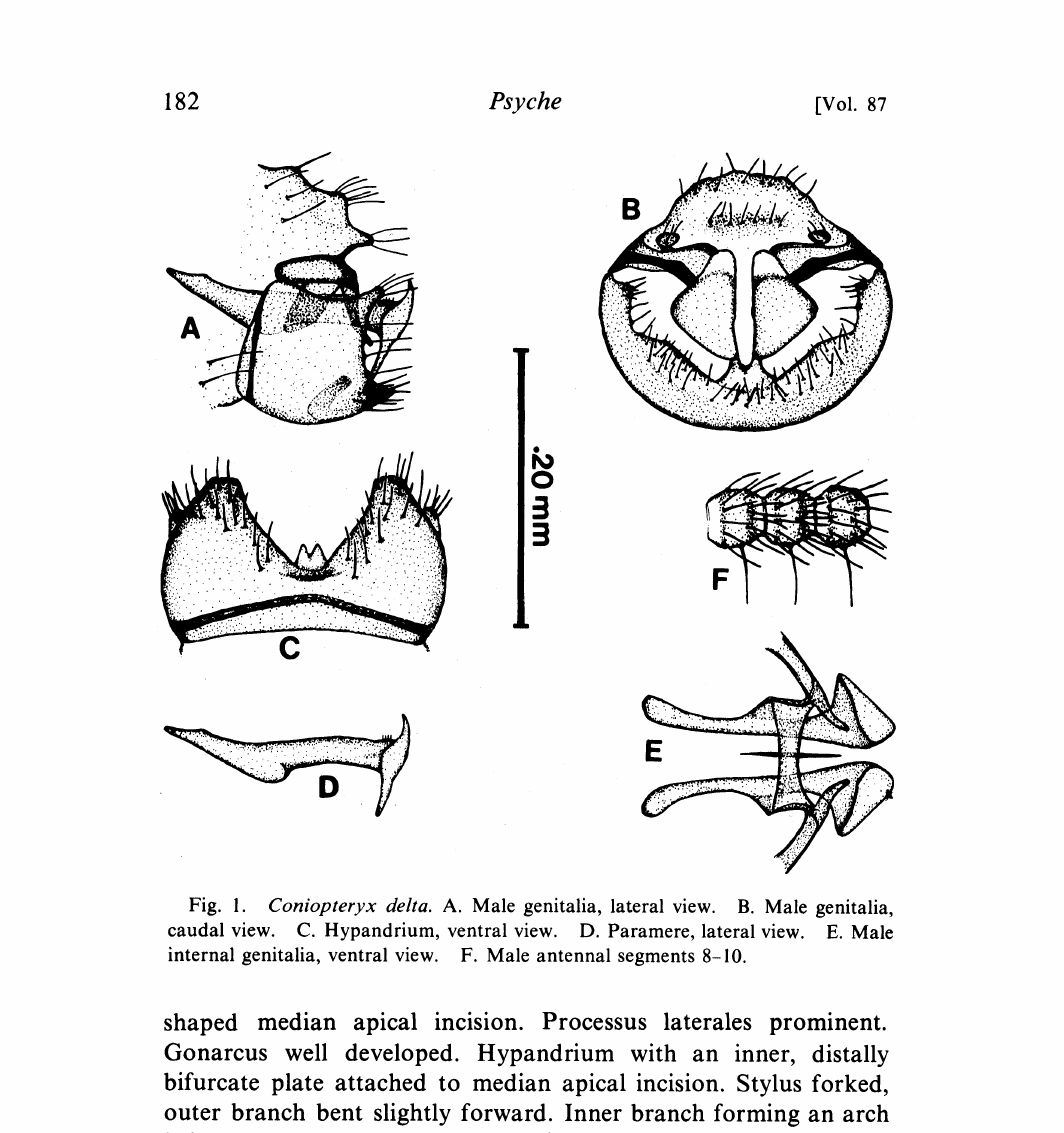
Fig. 1. Coniopteryx delta. A. Male genitalia, lateral view. B. Male genitalia, caudal view. C. Hypandrium, ventral view. D. Paramere, lateral view. E. Male internal genitalia, ventral view. F. Male antennal segments